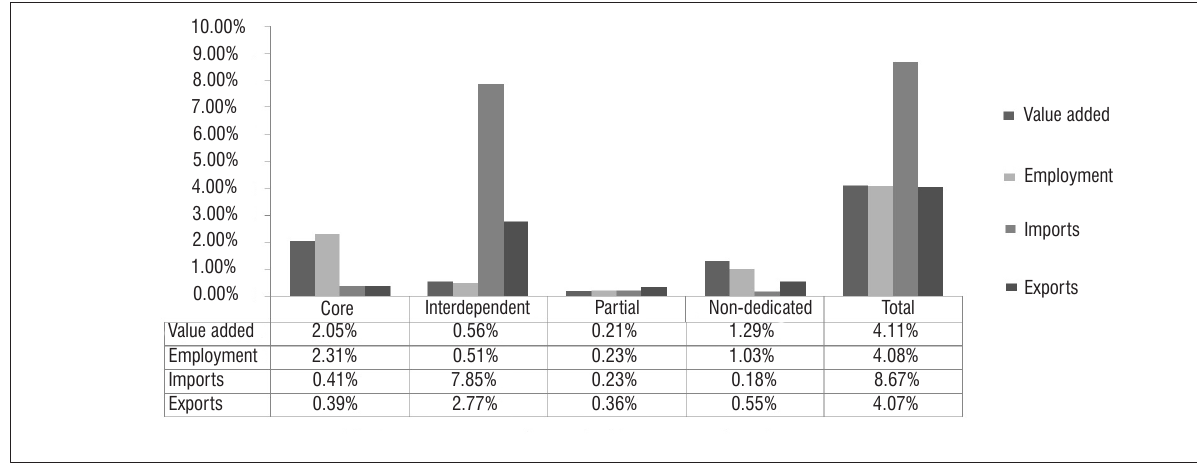
Contribution of the different categories of copyright-based industries to the South African economy in 2009.